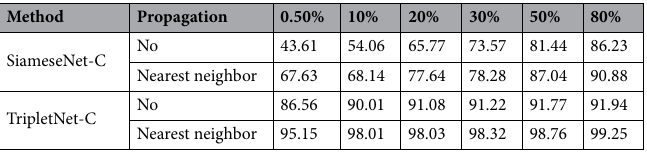
Table 2. Comparison of accuracy of different semi-supervised metric learning in TCIA.